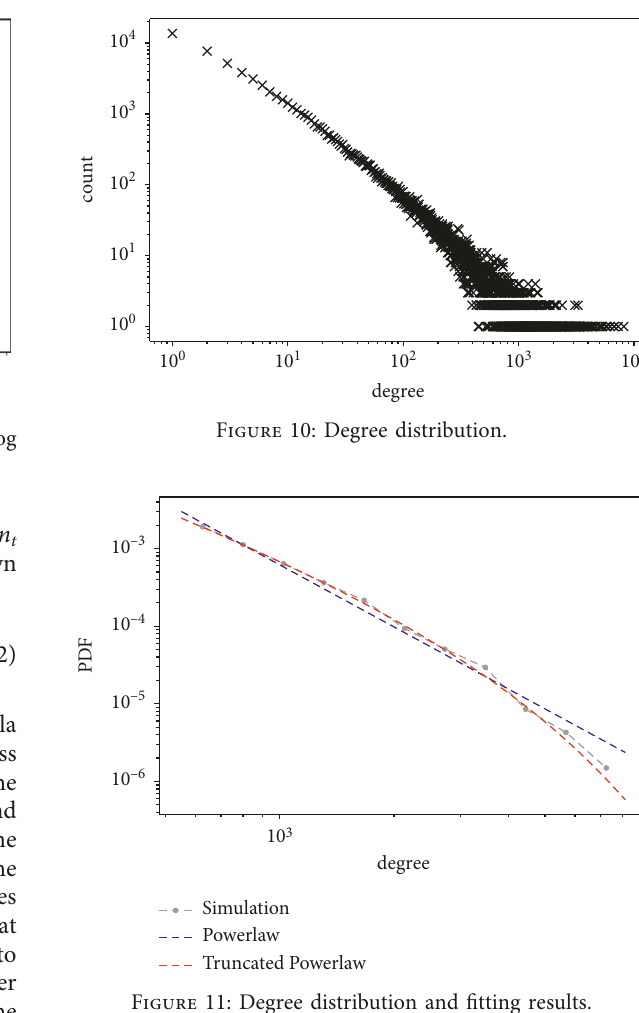
Figure 11: Degree distribution and fitting